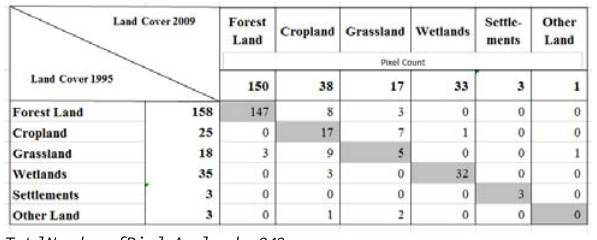
Table 2. Result of Analyzed Pixels for LC Change from 1995 to 2009